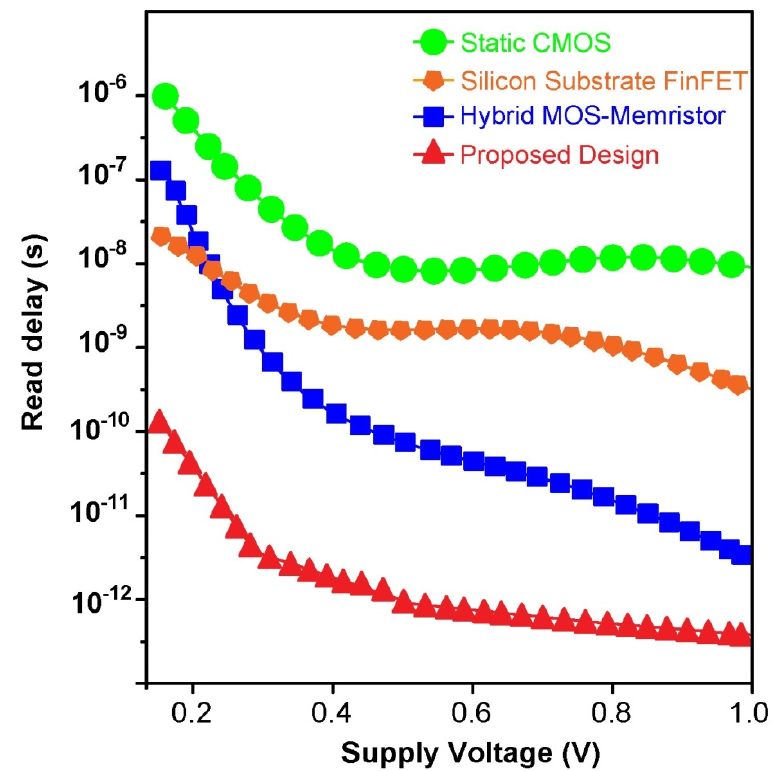
Figure 13. Read delay comparison of hybrid FinFET and Ti/SiO 2 /Si(n++)/TiN Memristor 6T-SRAM and traditional SRAM designs for various supply voltages.